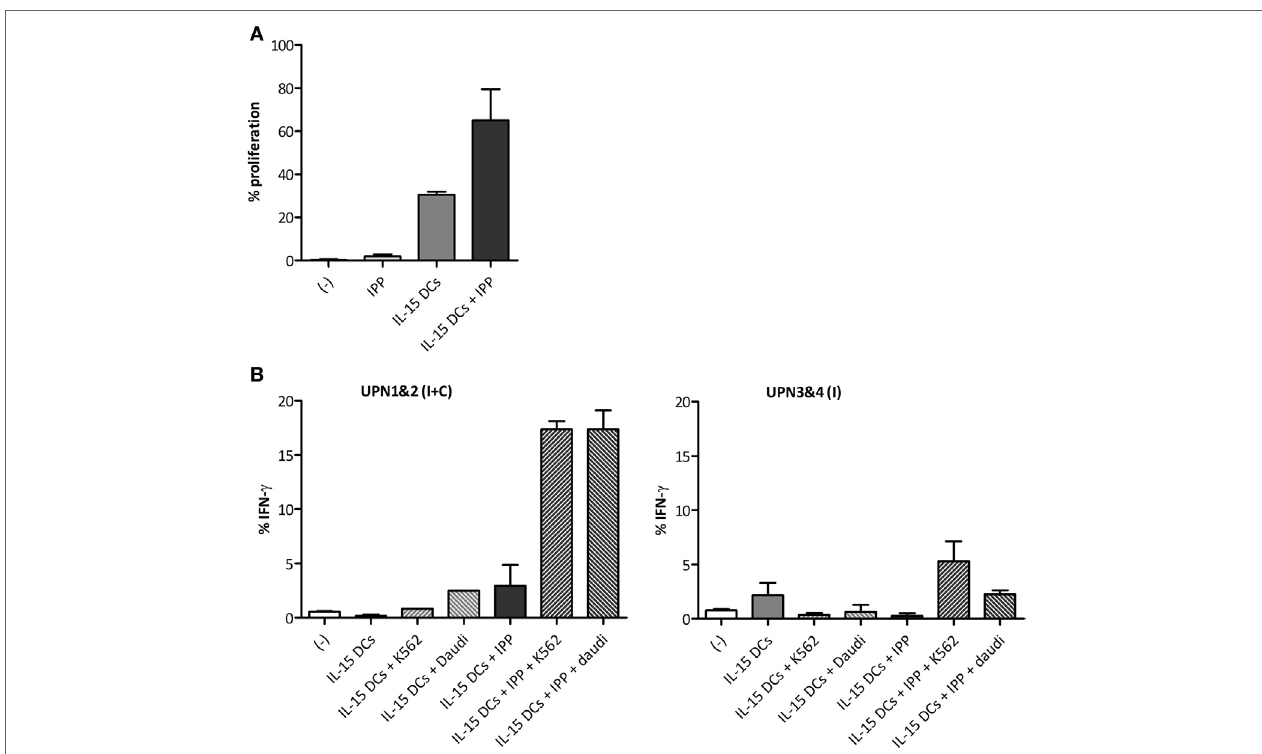
FigUre 5 | Functional activation of γδ T cells of acute myeloid leukemia (AML) patients by IL-15 dendritic cells (DCs). (a) Bar graphs depict γδ T cell proliferation upon 5-day culture ( − ) with isopentenyl pyrophosphate (IPP), IL-15 DCs (E:T ratio = 1:10) or IL-15 DCs + IPP. (B) Percentage IFN- γ -positive γδ T cells after overnight culture ( − ) with IPP, IL-15 DCs (E:T ratio = 1:10), and/or tumor cells (E:T ratio = 1:10) measured by flow cytometry for four AML patients in first complete remission. The IFN- γ production by γδ T cells of unique patient number (UPN)1&2 and UPN3&4 is shown separately, as they differ from each other in response to stimuli. Blood from UPN1&2 and UPN3&4 was drawn after termination of induction and consolidation chemotherapy (I + C) and induction chemotherapy (I), respectively. No statistics were performed due to limited